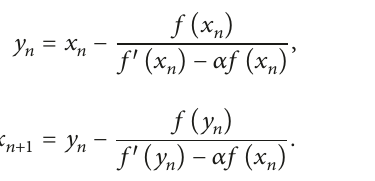
Algorithm 11. The iterative scheme which will compute